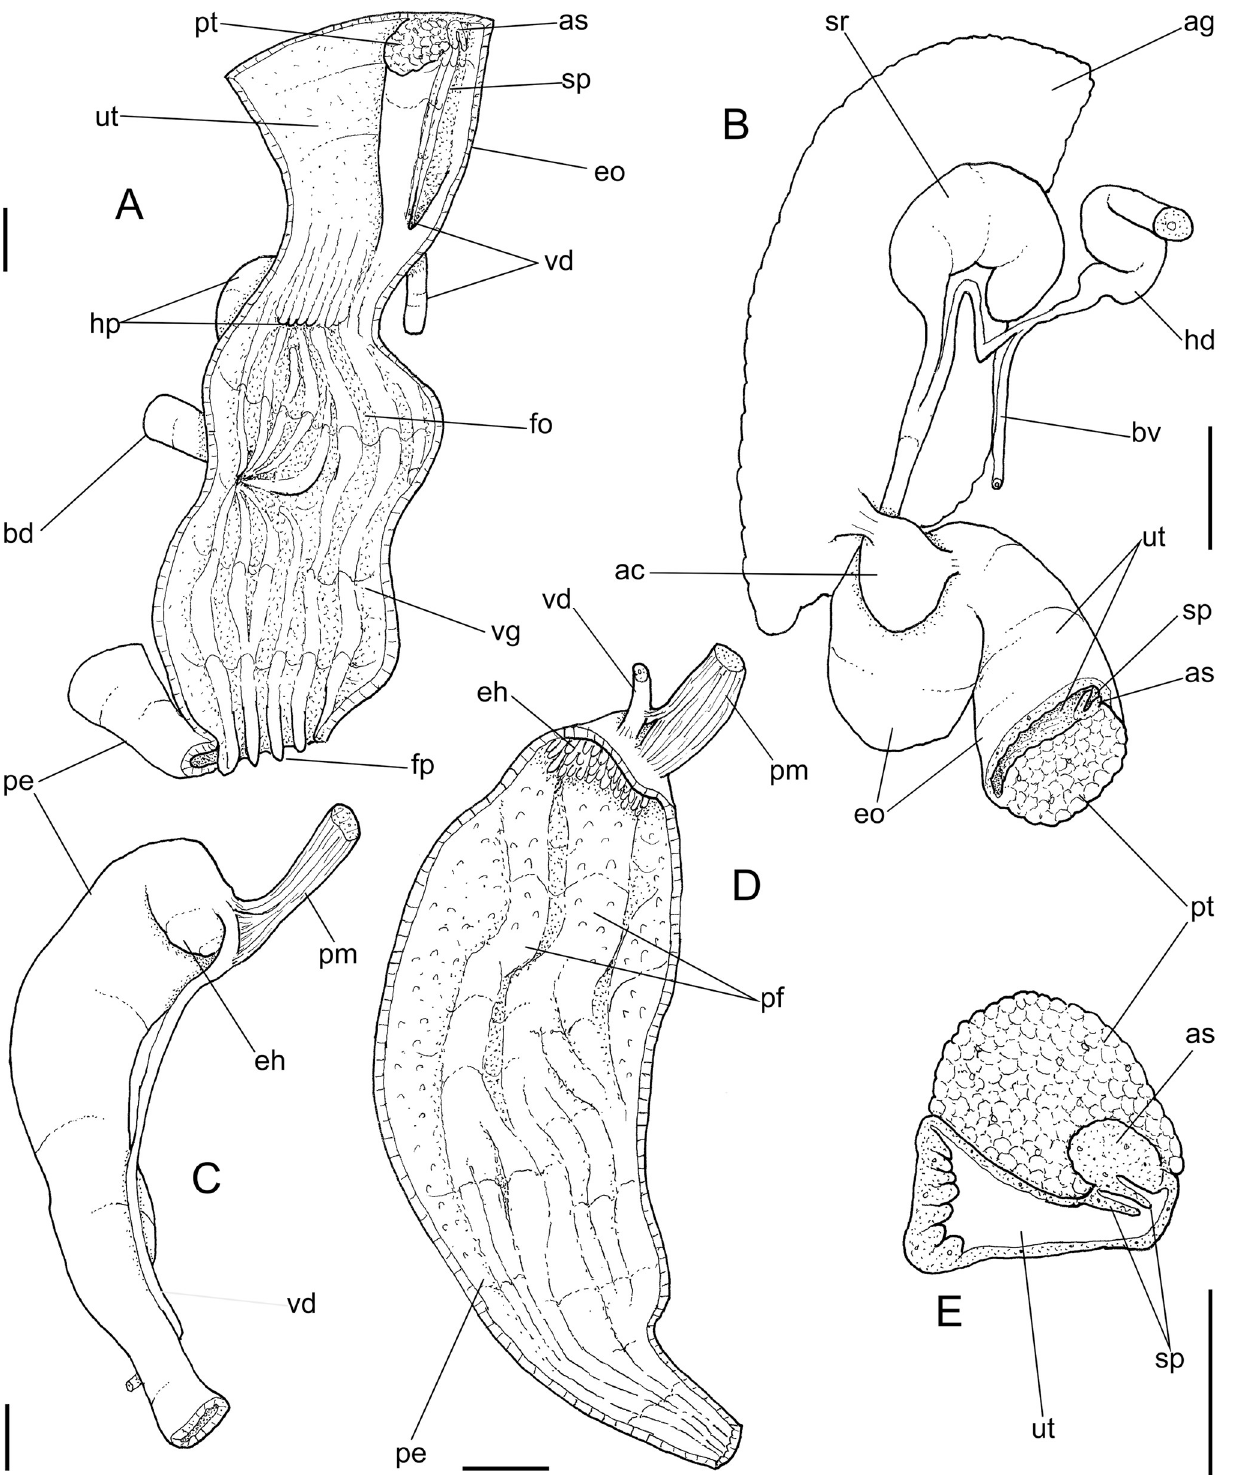
Fig 4. Anthinus multicolor , anatomy. (A) anterior half of genital tubes, opened longitudinally. (B) carrefour region of genitalia and posterior region of spermoviduct, albumen gland seen as transparent. (C) penis, ventral view. (D) same, opened longitudinally showing inner surface. (E) spermoviduct, transverse section in its middle region. Scales = 1